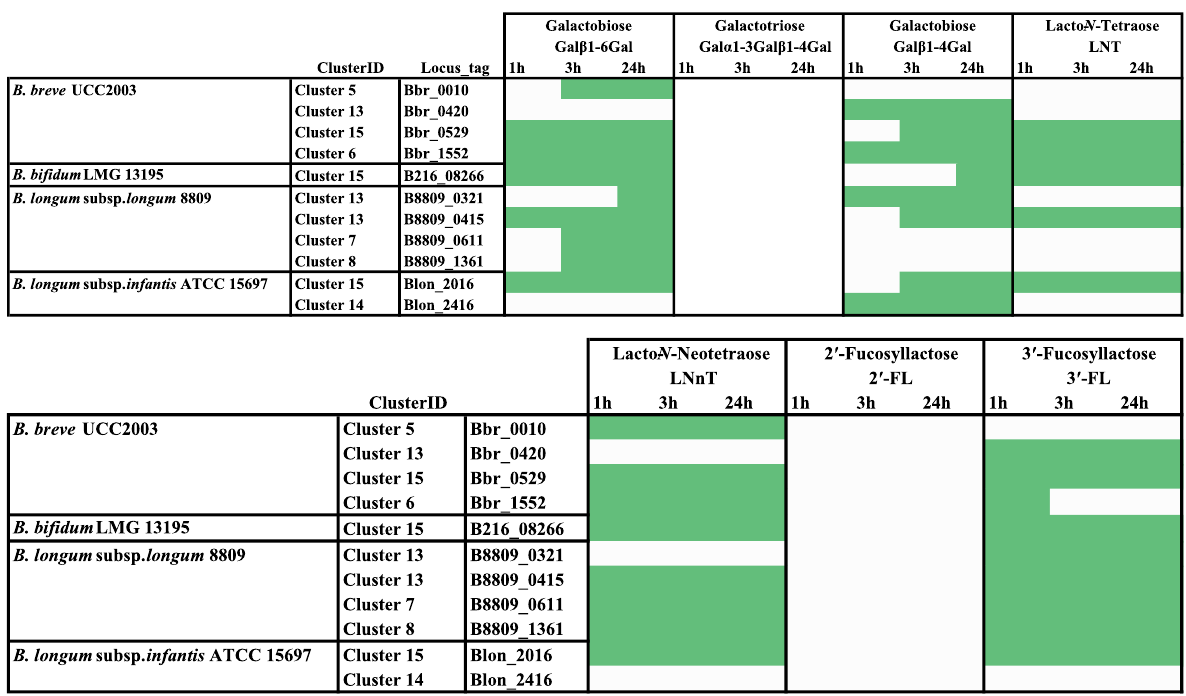
Table 5 Hydrolysis performance of the 11 selected β-galactosidases tested on galactobiose, galactotriose, LNT, LNnT, 2 ′ -FL and